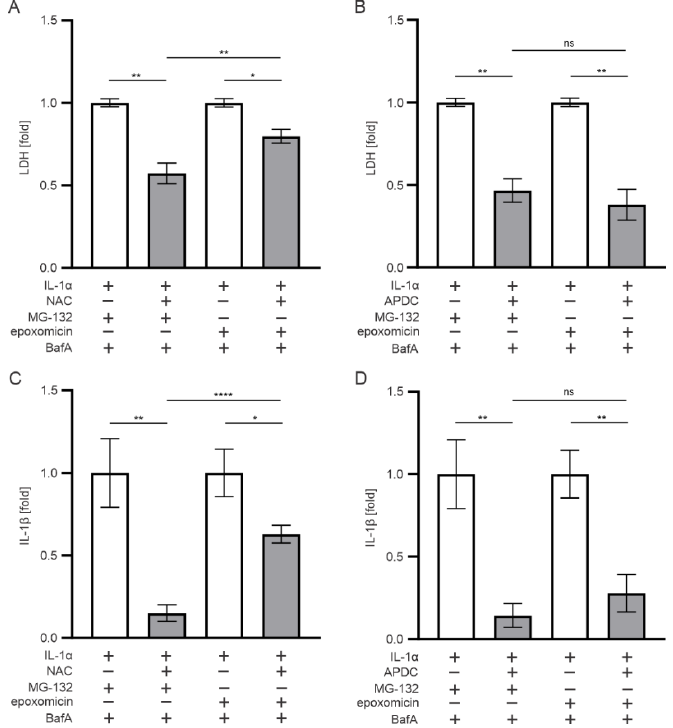
Figure 7. The effect of antioxidants on ( A , B ) cell viability and ( C , D ) IL-1 β production in ARPE-19 cells. Data were combined from three independent experiments, with four parallel samples in each group. The results are presented as mean ± SEM. * p ≤ 0.05, ** p ≤ 0.01, **** p ≤ 0.0001; ns, not significant.